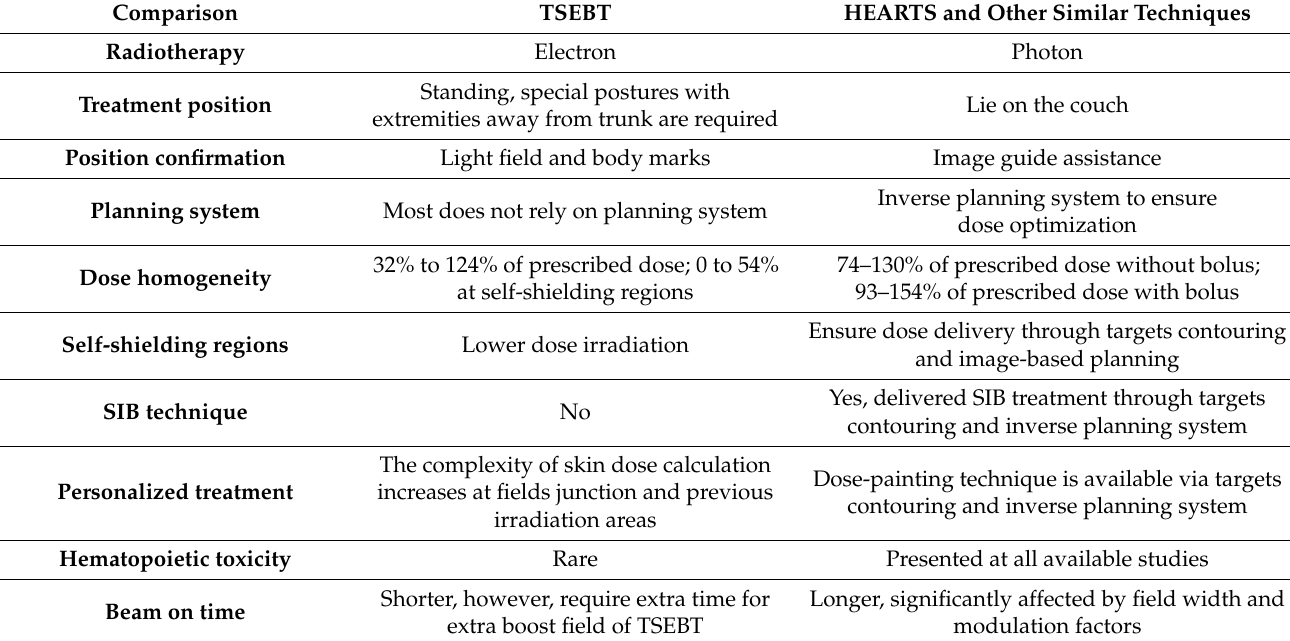
Table 5. Comparison of TSEBT and HEARTS and other similar